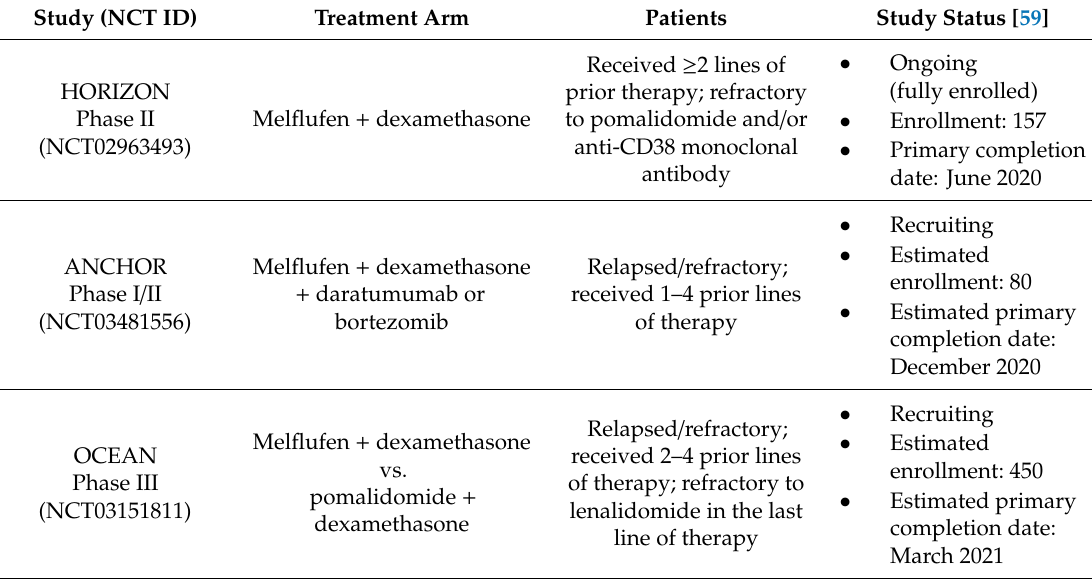
Table 4. Ongoing studies of melflufen in multiple